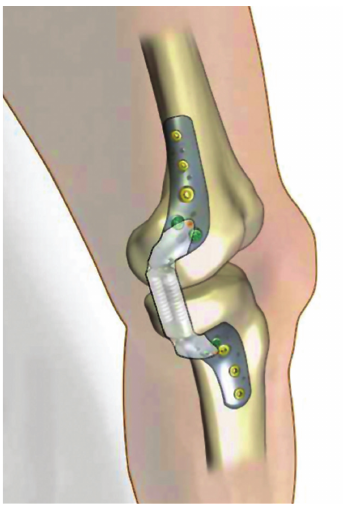
Figure 1: Medial view of the KineSpring Knee Implant System.